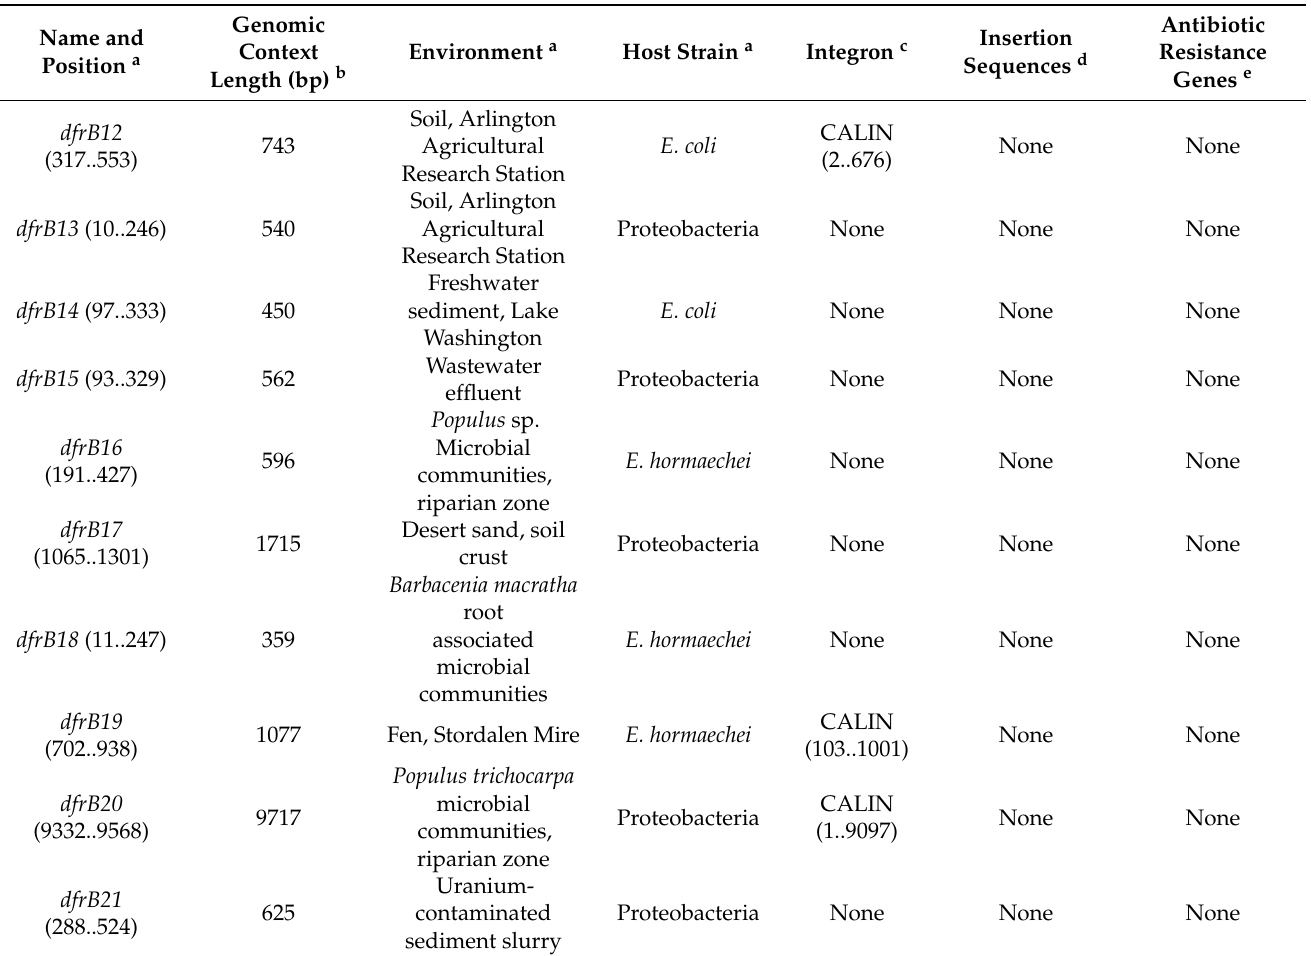
Table 1. Genomic context analysis of dfrB12–21